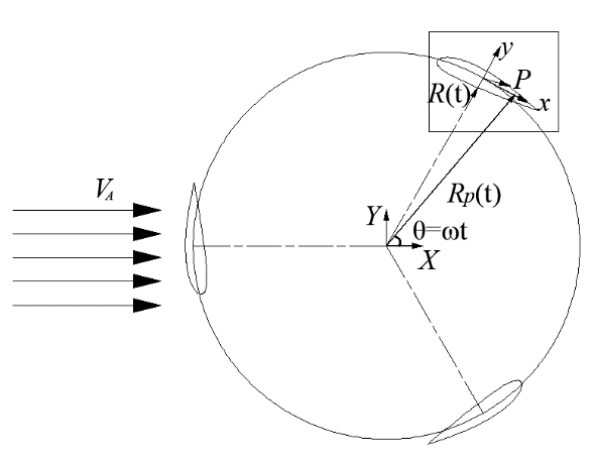
Figure 1. Reference coordinate system.